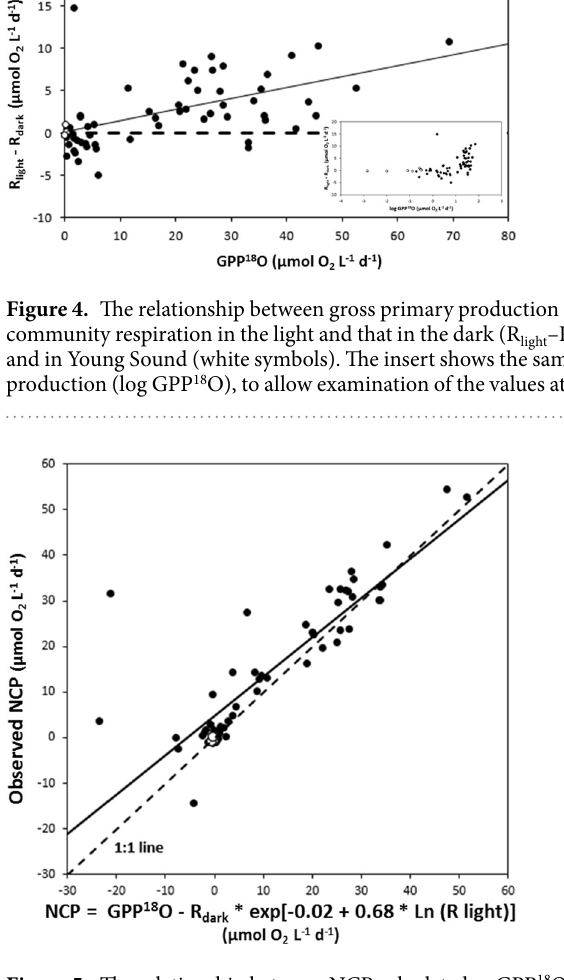
Figure 5. The relationship between NCP calculated as GPP 18 O - R dark * exp[ − 0.02 + 0.68 * Ln (R light)] and observed net community production (NCP) in the Svalbard region (black symbols) and in Young Sound (white symbols). The solid line shows the fitted regression equation: y = 0.86 ( ± 0.06) × + 4.81 ( ± 1.19) (R² = 0.74, p < 0.001, N =